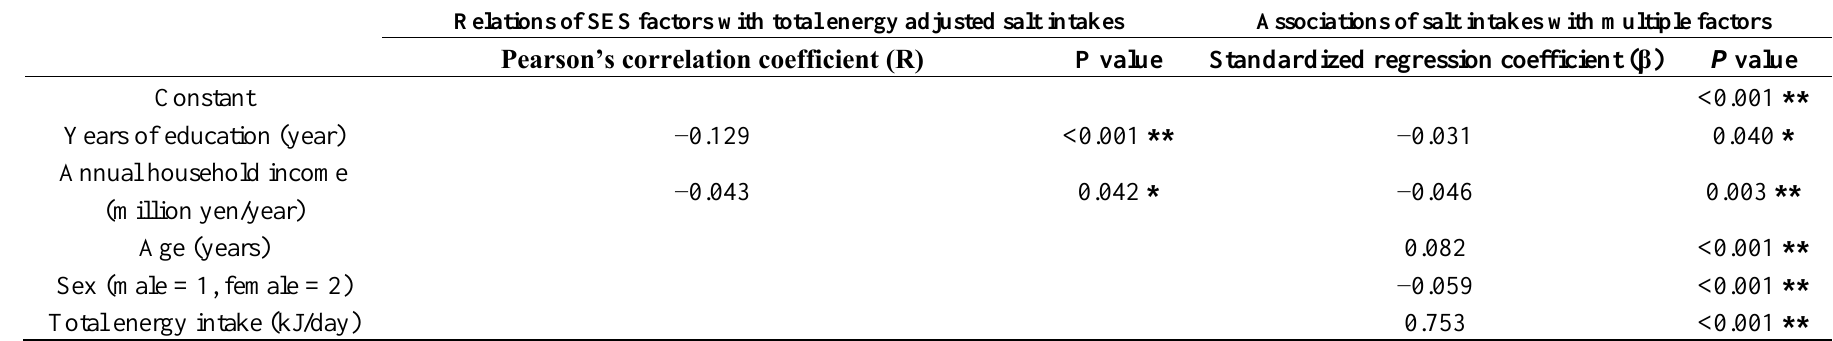
Table 3. The associations of daily salt intakes with SES factors (years of education and adjusted annual household